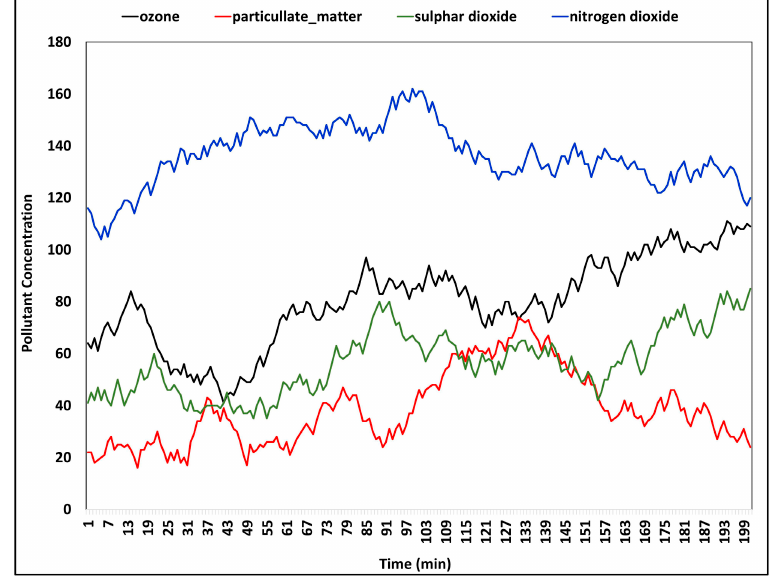
Figure 9. Pollution measurements analysis of Aarhus, Denmark.